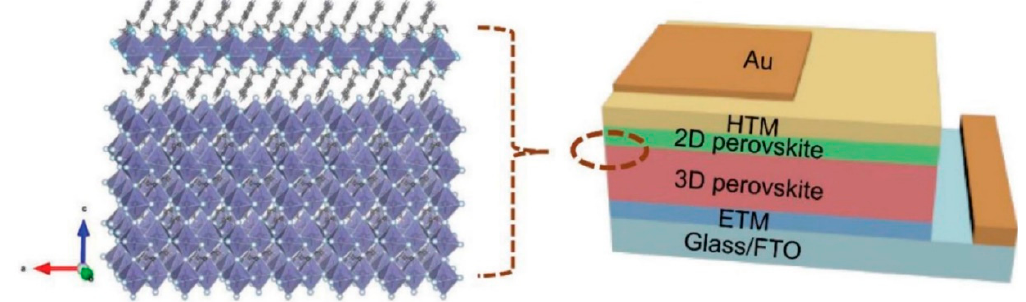
Figure 1. Illustration of the 3D/2D bilayered perovskite structure and perovskite solar cell (PSC) device. Reprinted with permission from Ref. [28] Copyright 2018 Wiley-VCH.